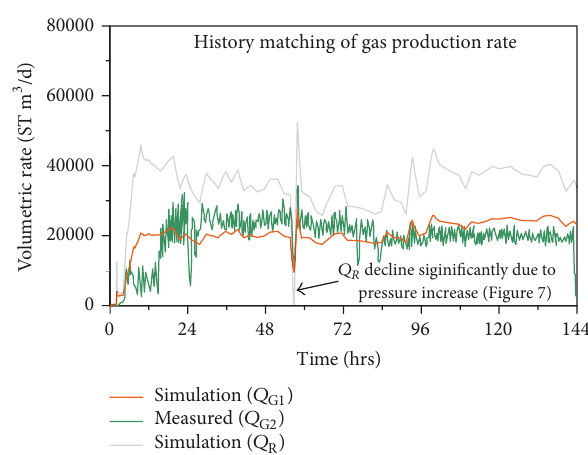
Figure 8: Gas release ( 𝑄 R ) and production ( 𝑄 G ) rates during the 6-day production test at the AT1 site.